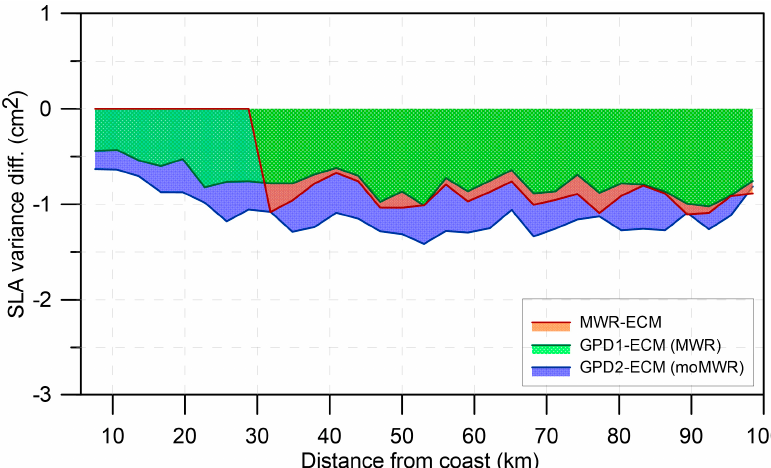
Figure 21. Variance differences of SLA versus distance from coast for SLA datasets computed using the WTC from MWR and ECMWF (orange), those from GPD1 and ECMWF (blue) and those from GPD2 and ECMWF (green) over the period of S3A cycles 05 to 16. In the first case only valid MWR points were selected while in the last two cases all points with valid SLA were considered